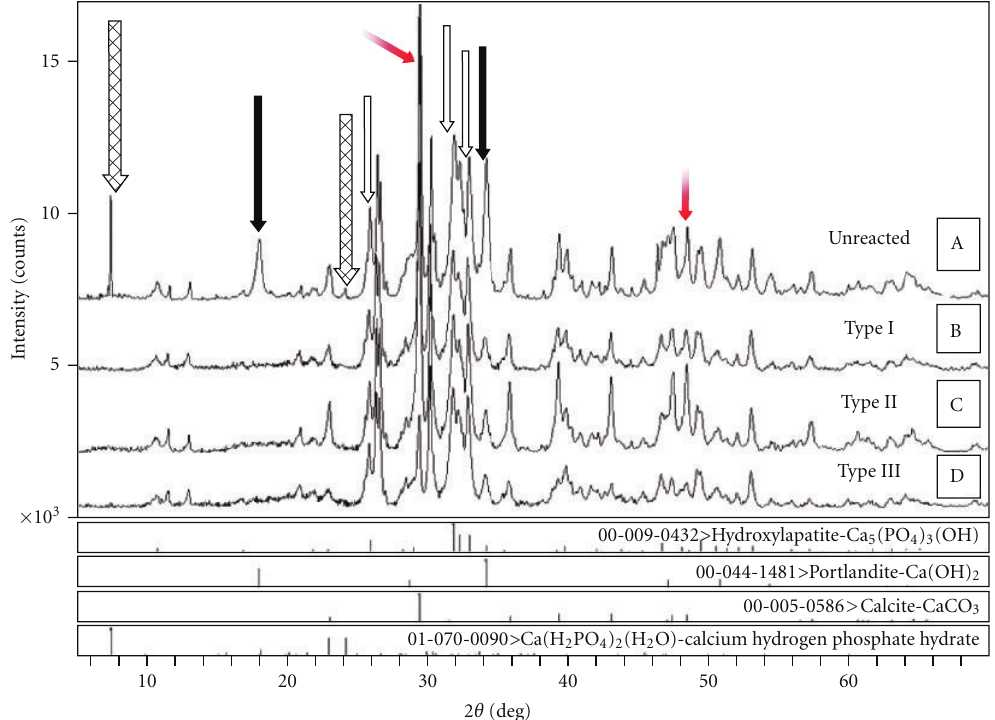
Figure 5: X-ray di ff raction pattern of the three types of polymeric cements (Type I, Type II, and Type III CPCs). (A) Unreacted powder component. (B) Set product of Type I cement. (C) Set product of Type II cement. (D) Set product of Type III cement. Di ff erent arrows indi- cating the characteristic peaks of the di ff erent crystalline phases of the X-ray di ff raction pattern; cross-hatched arrows indicate the crystal phase of calcium hydrogen phosphate hydrate, black arrows portlandite, grey arrows hydroxyapatite, and gradient arrows